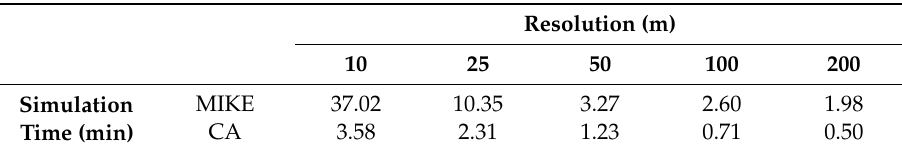
Table 3. Comparison of simulation time with di ff erent grid size.